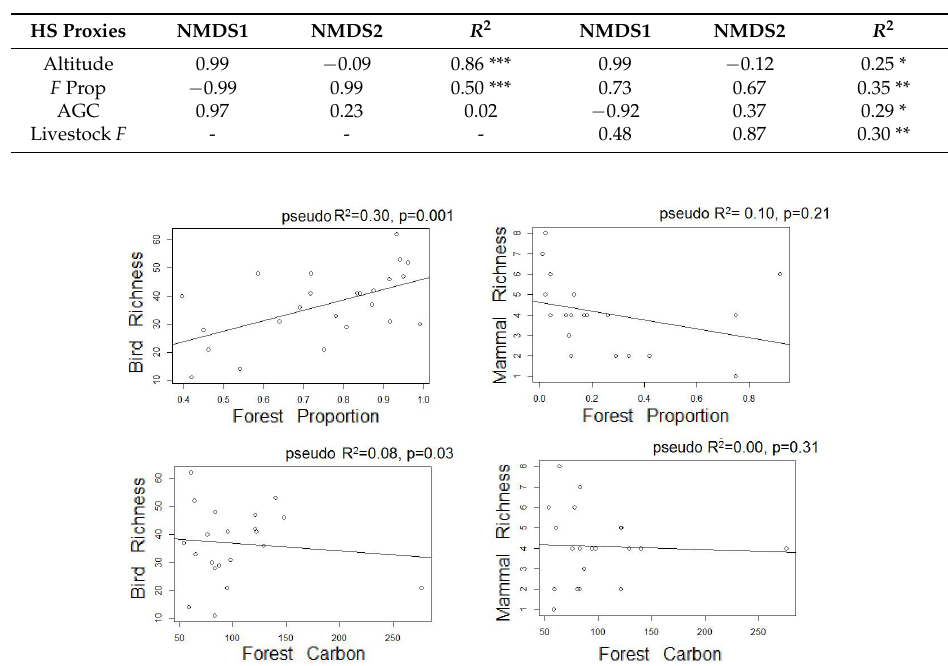
Table 3. Pearson correlations among axes 1 and 2 scores and habitat suitability proxies ( F Prop = Forest proportion; AGC = above-ground-carbon; Livestock F = livestock frequency) for birds (left) and medium-large mammals (right). Asterisks represent significance at the 0.1 (*), 0.05 (**), and 0.01 (***) levels (due to incomplete sampling the correlation between livestock frequency and the ordination axes was not assessed for birds).